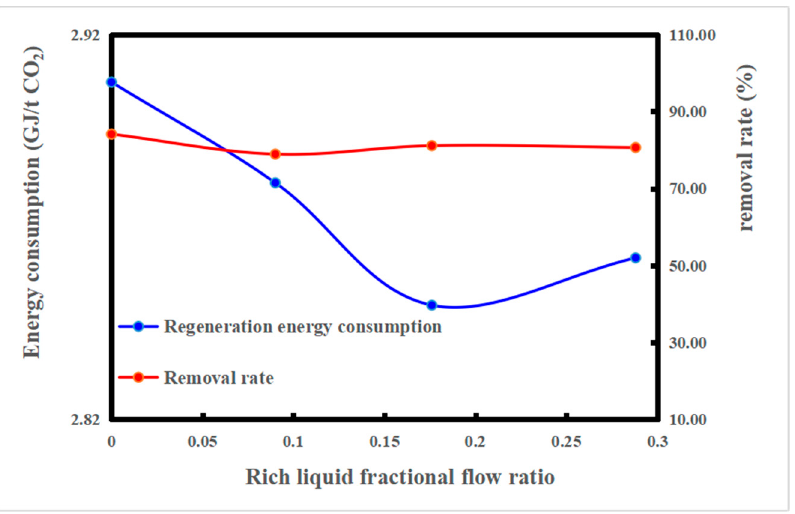
Figure 9. Effect of the rich liquid fractional flow ratio on the regeneration energy consumption and removal rate. removal